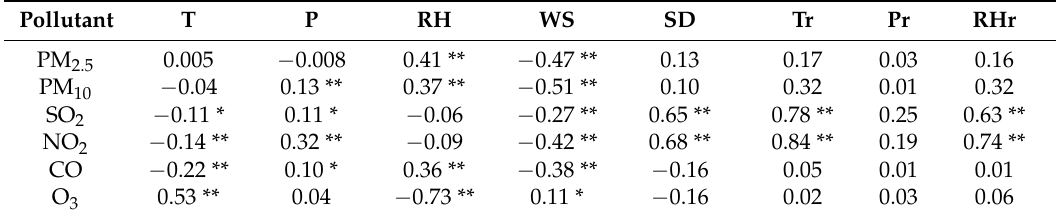
Table 2. The relationship between the mass concentration of air pollutants and the